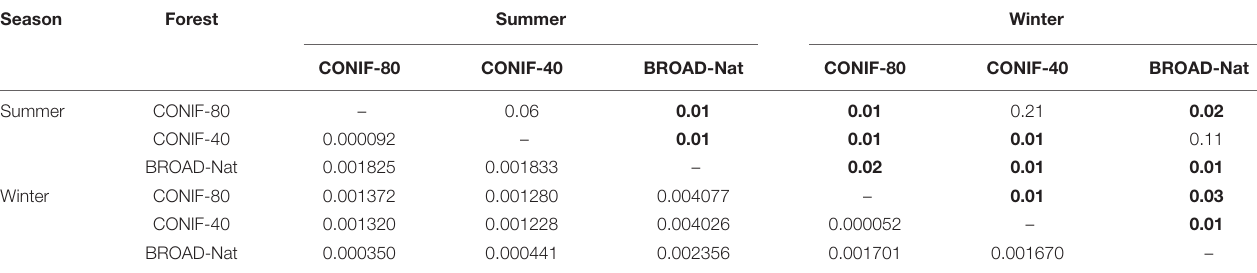
TABLE 2 | Statistical significance ( P -value) of differences among forest soil communities using K -shuff analysis a .